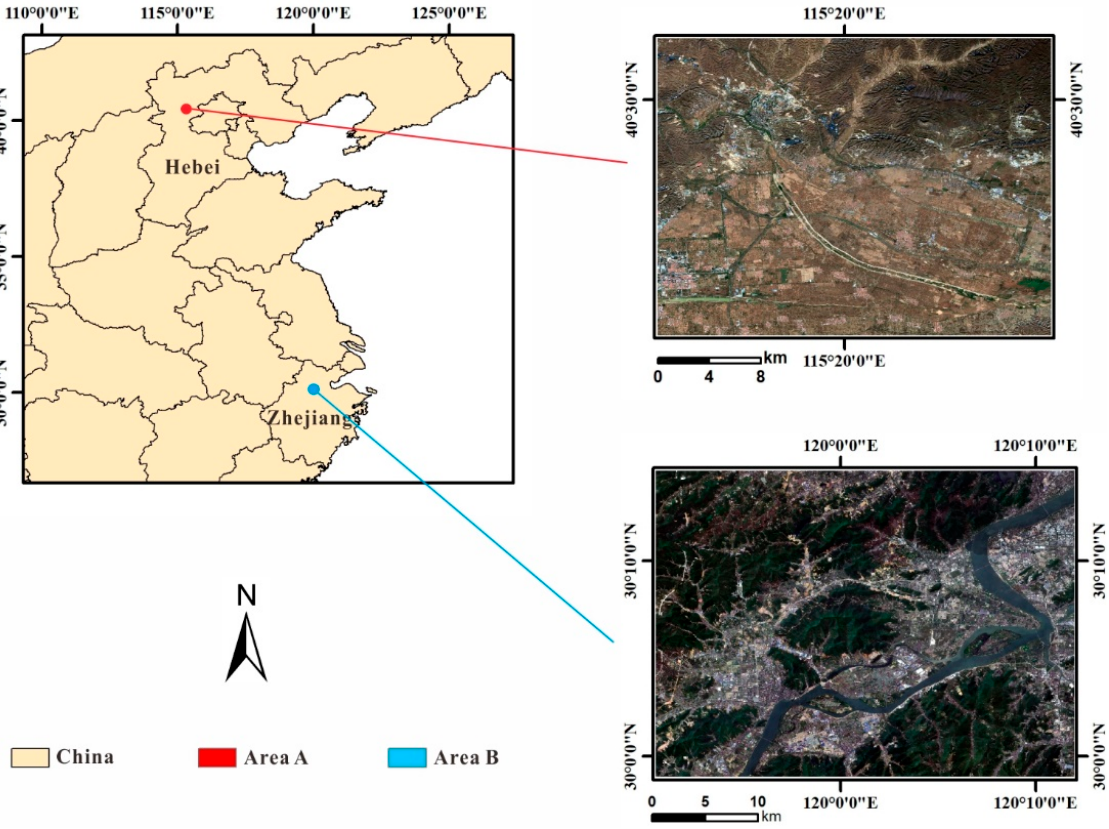
Figure 1. Locations of the Area A and Area B in China.